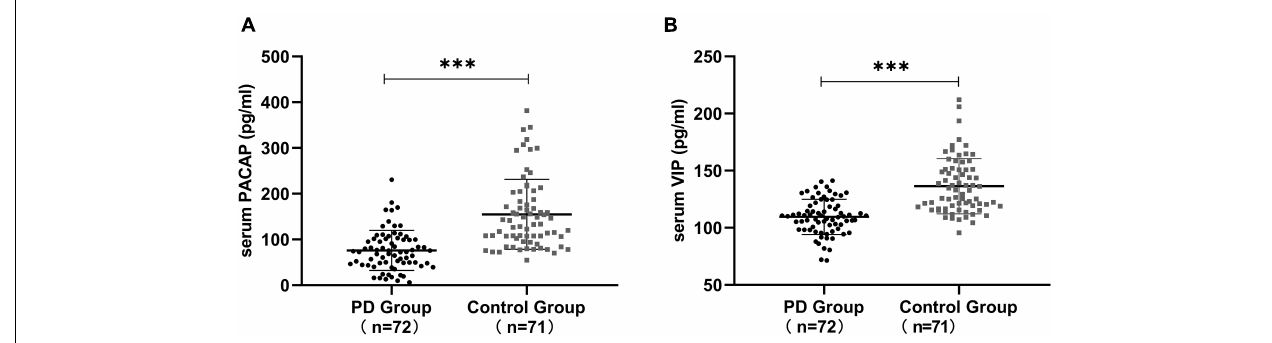
FIGURE 1 | Serum PACAP and VIP levels in Parkinson’s disease (PD) patients and in healthy controls. (A) Lower serum PACAP levels were detected in PD patients than in healthy controls. (B) Lower serum VIP levels were detected in PD patients than in healthy controls. Values are presented as the mean ± standard deviation.